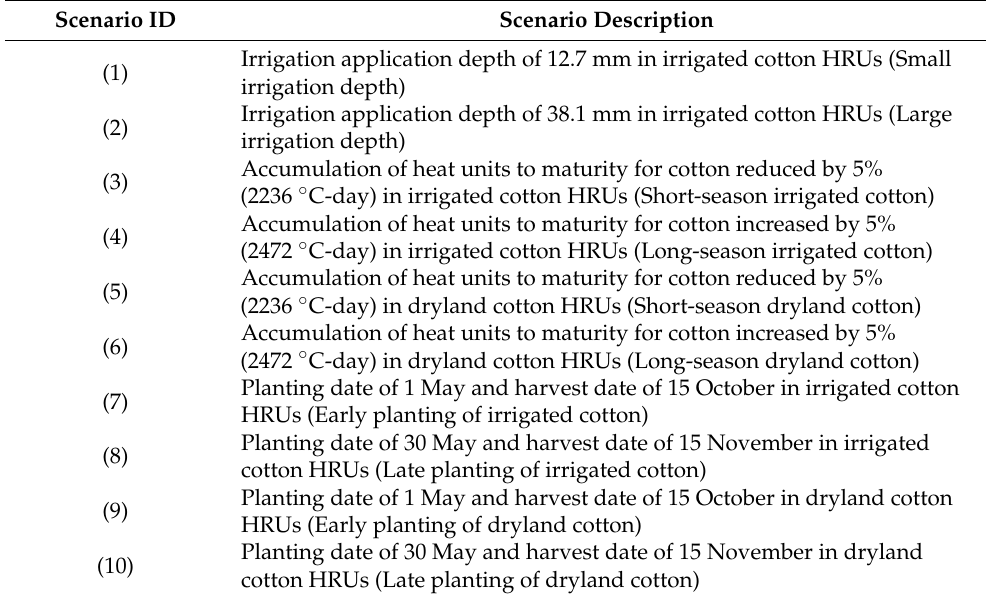
Table 3. Descriptions of simulated scenarios in the Double Mountain Fork Brazos